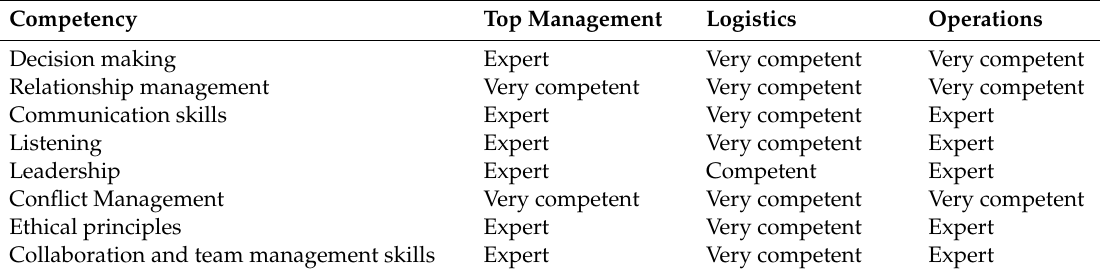
Table 3. Development of core competencies at each level of nurse